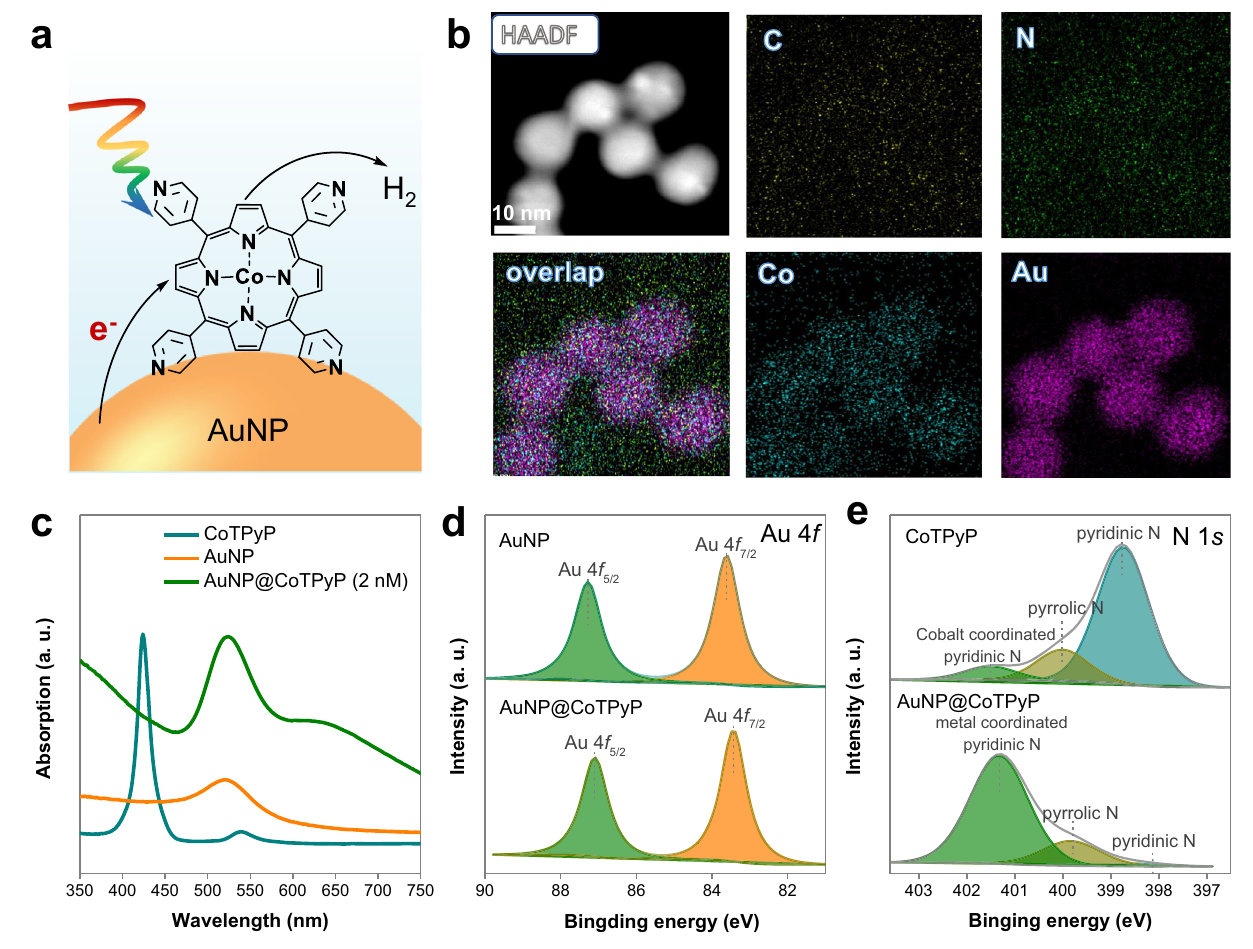
Fig. 1 | Schematic illustration and characterization of the AuNP@CoTPyP nanostructures. a Schematic illustration of the enhanced photocatalytic HER in AuNP@CoTPyP. b STEMimageofAuNP@CoTPyPandcorrespondingEDSmapping